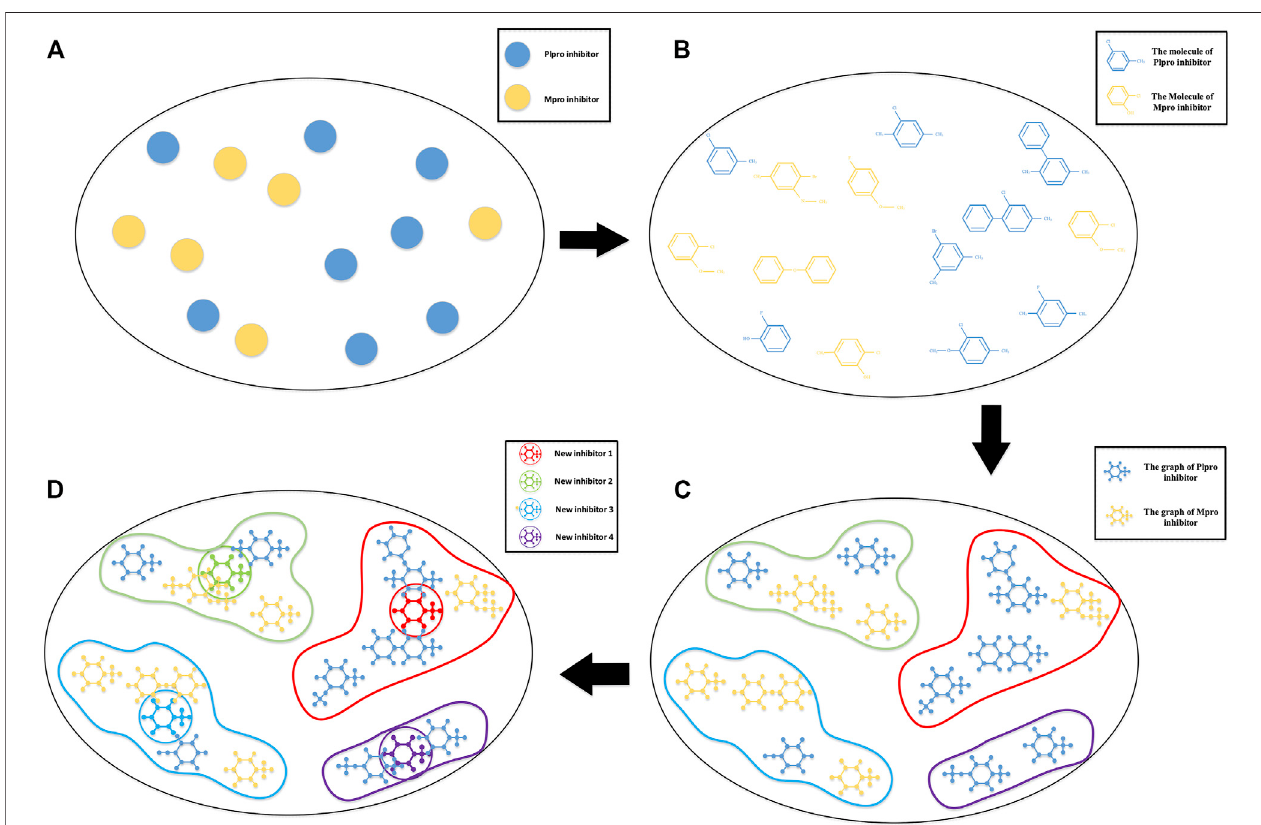
FIGURE 1 | Schematic diagram of COVID-19 drug discovery. (A) A sketch map of main protease (Mpro) and active papain-like protease (PLpro) inhibitors with higher activity in a high-dimension space; (B) the molecular structure of these inhibitors in high-dimension space; (C) a graph representation of SARS-CoV PLpro and SARS-CoVMproinhibitors basedontheirthree-dimensionalmolecularstructure.Thetopologicalinformationoftheinhibitor moleculesisreserved,andtheinhibitorsare groupedbyhierarchicalclustering – basedKroneckerproduct( p , m )-norm; (D) anoveliterativealgorithm – basedKroneckerproduct( p , m )-normisusedtogenerate the cluster centers of individual